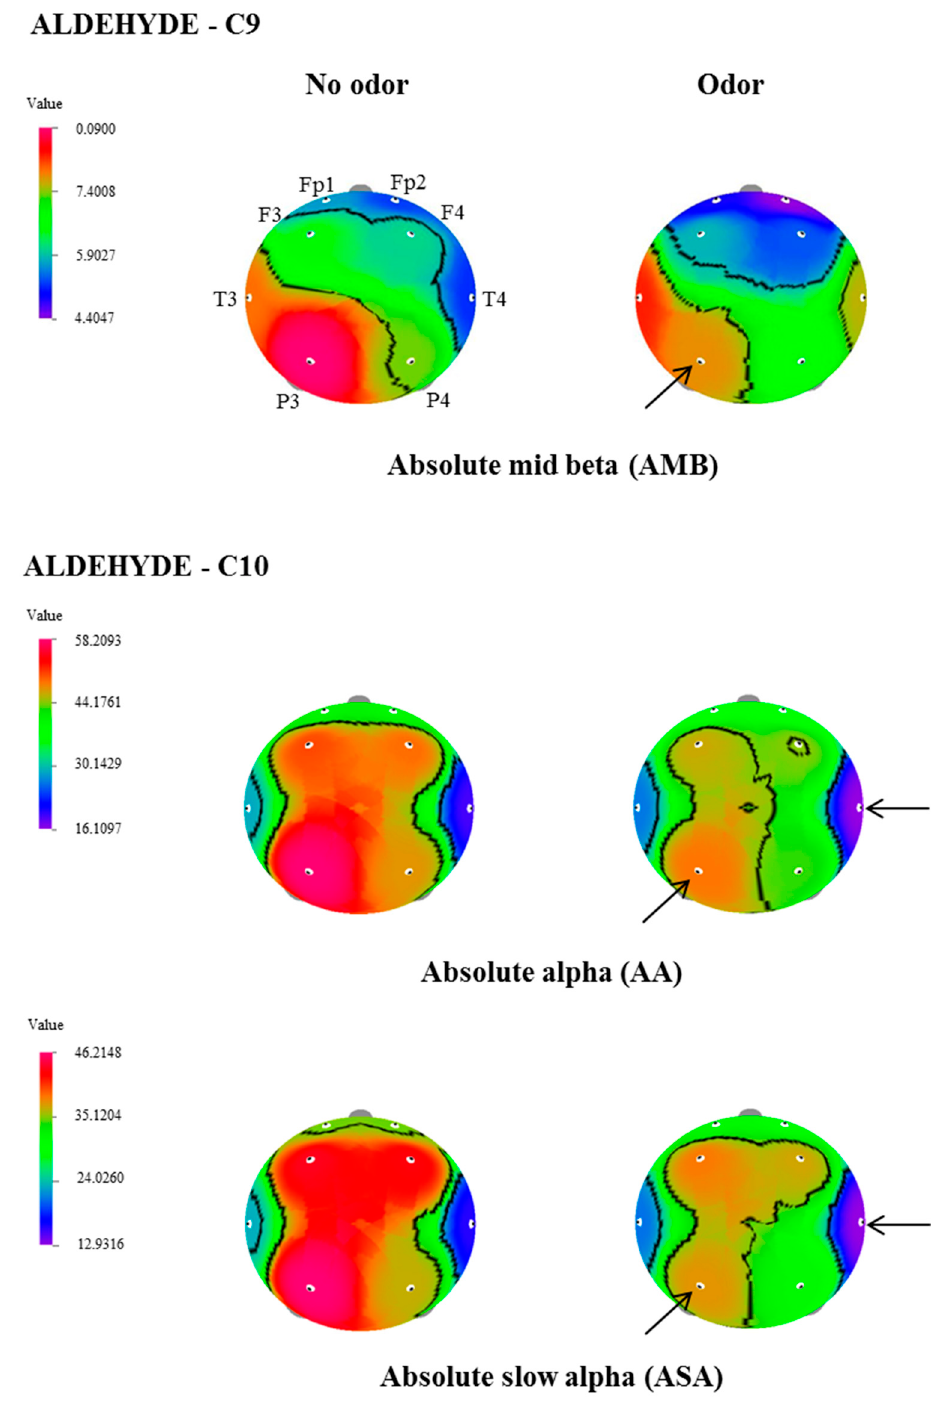
Figure 1. The t-Mapping of electroencephalographic (EEG) power spectrum changes during the binasal inhalation of aldehydes (C9 and C10). Fp1, left prefrontal; Fp2, right prefrontal; F3, left frontal; F4, right frontal; T3, left temporal; T4, right temporal; P3, left parietal; P4, right parietal. Arrows show significant changes in the regions during the inhalation of C9 and C10.